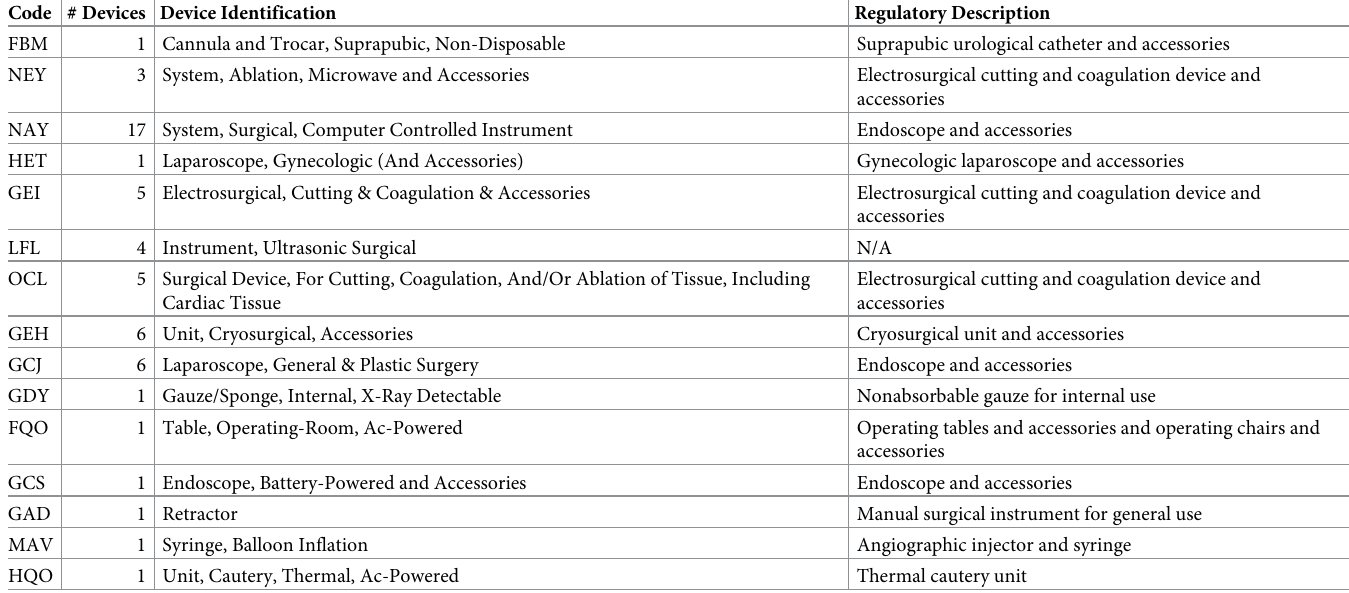
Table 2. Product codes in Da Vinci Si